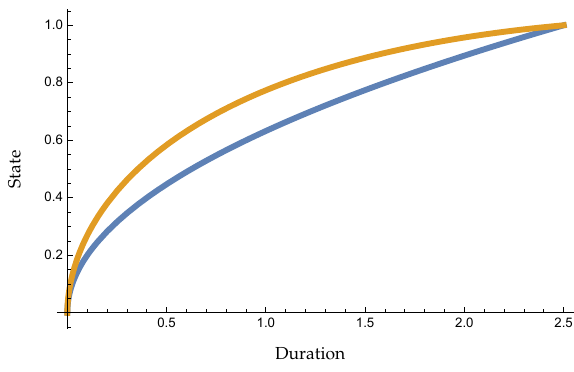
Figure 15. Strategy OPT (Blue) and online strategies for t = 0.312, z = 1.1